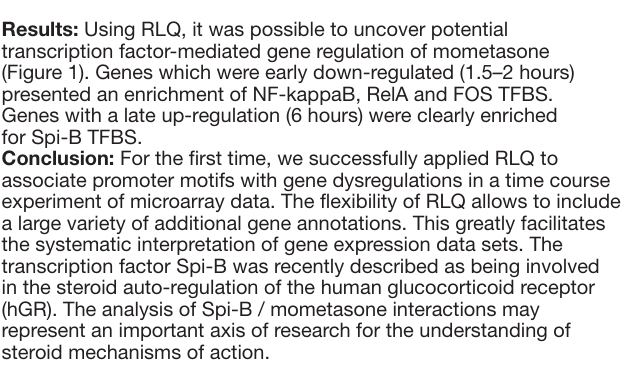
Figure 1: RLQ analysis of the importance of transcription factor binding sites for the mechanism of action of mometasone in proliferating primary lung fibroblasts in